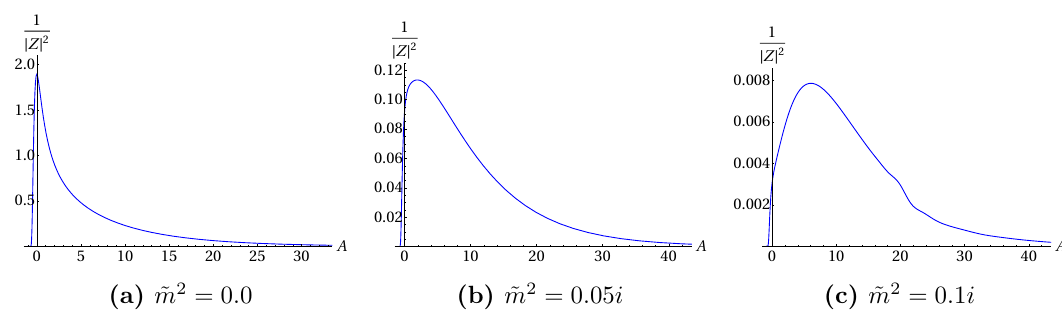
Figure 15. Three one-dimensional slices of the holographic probability distribution in a vector toy model dual of eternal in(cid:13)ation, for three di(cid:11)erent values of ~ m 2 . Remarkably, the distribution qualitatively agrees with that obtained using bulk methods and shown in (cid:12)gure